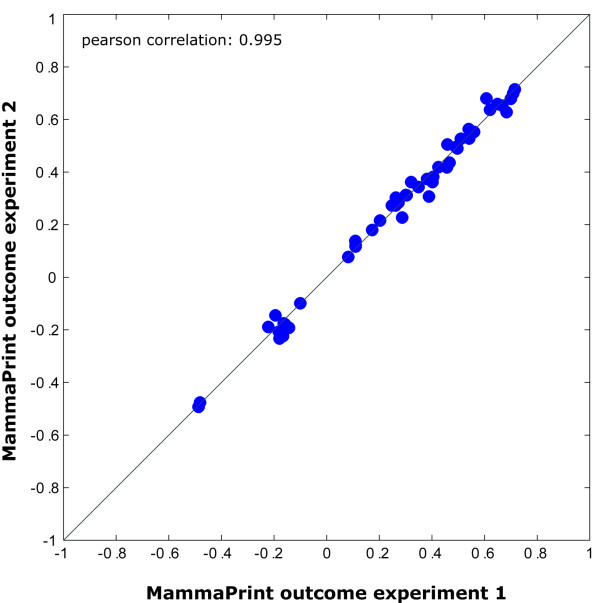
Custom array outcome of replicate experiments. Cosine correlation to the good prognosis template is plotted, and is highly similar between duplicate experiments.